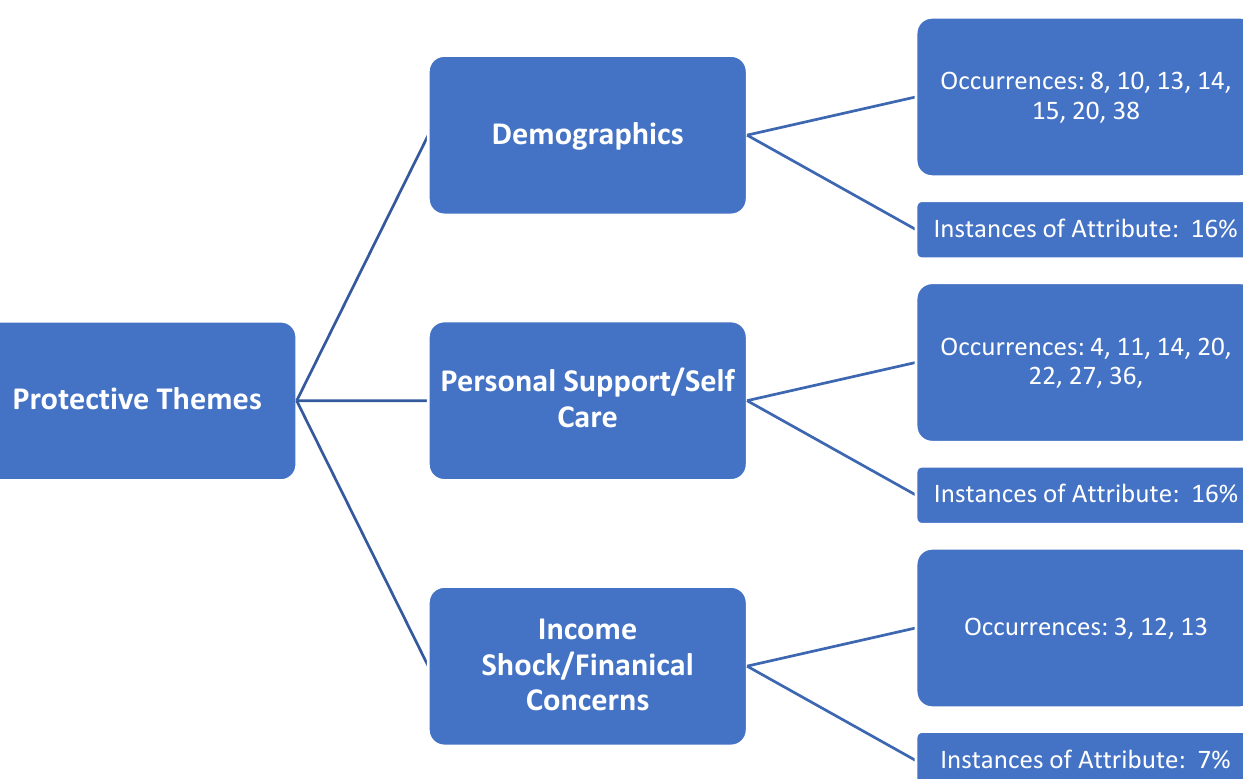
Figure 2. Identified themes (constructs) identified as protective factors of mental health distress during the COVID-19 pandemic in the United States.